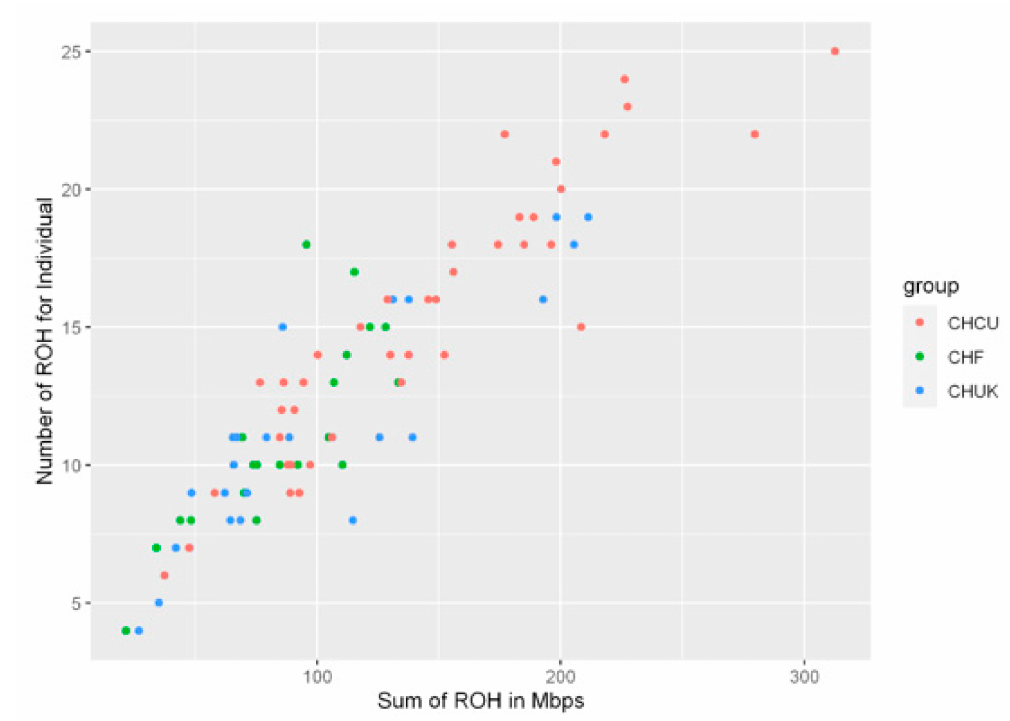
Figure 2. Relationship between the total number of runs of homozygosity (ROHs) > 4 Mb and the total length (Mbps) of genome in such ROHs for individuals from the three analyzed Charolais populations. Each dot represents an